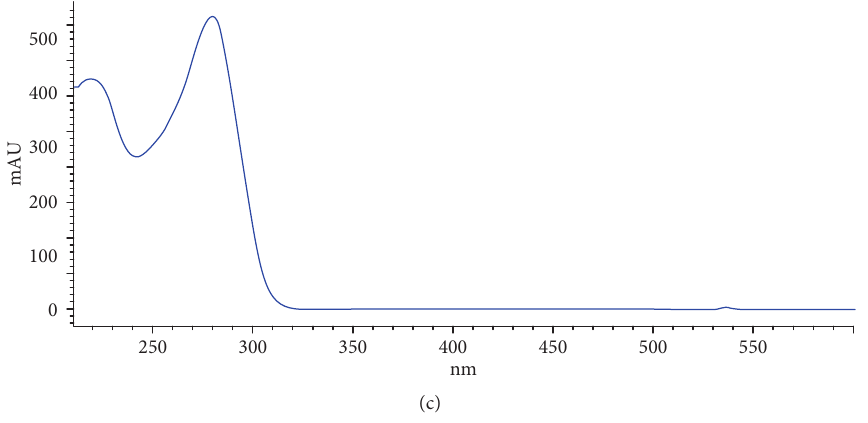
Figure 5: UV spectra of chloramphenicol (a), methylparaben (b), and propylparaben Table 1: Summary of validation results.